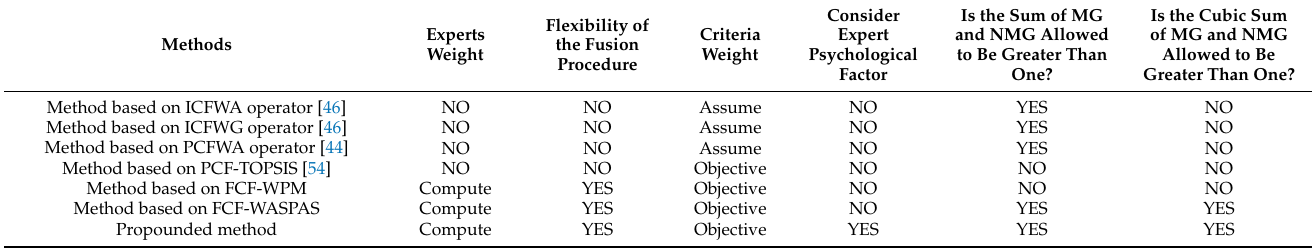
Table 11. Characteristic comparison between the propounded methods and extant